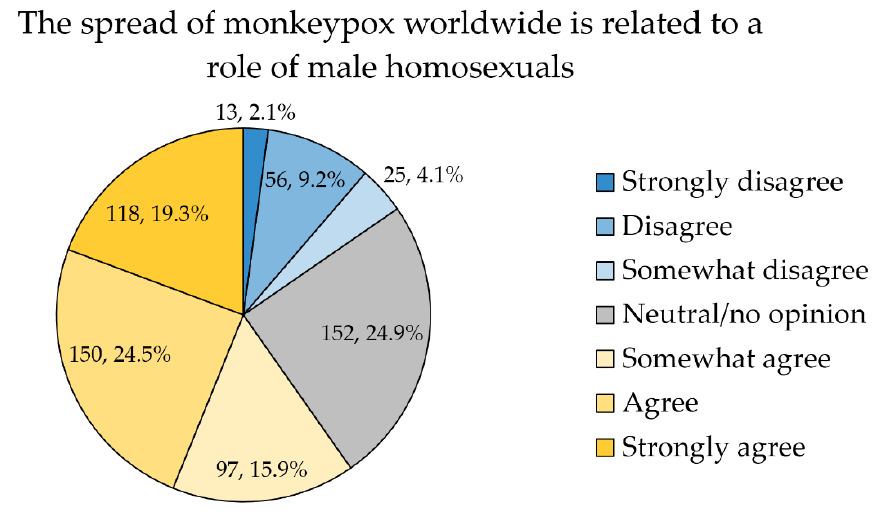
Figure 2. The overall level of monkeypox (MPX) knowledge in the study sample. Knowledge items that are marked with an asterisk represent incorrect statements. * Monkeypox knowledge items that are marked with an asterisk denote incorrect statements.